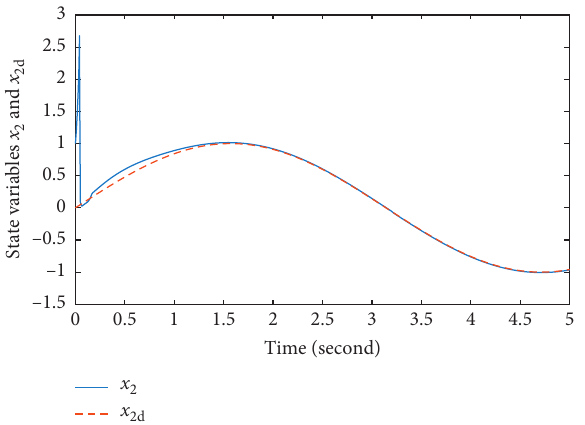
Figure 6: x and x with proposed control scheme (20). 2 2 d